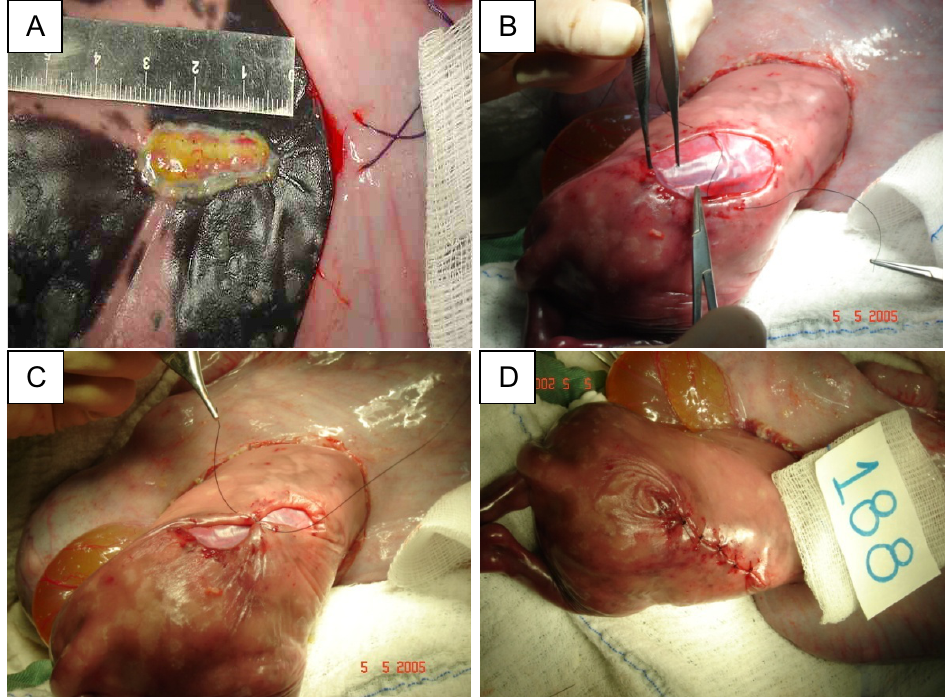
FIGURE 1 - . (A) External aspect of MMC-like defect created at 75 days, after 3 weeks of intrauterine exposure (100 days of gestation), note the striking resemblance of an espina bifida in the human fetus. (B) Skin surrounding defect has been dissected and the interface material is covering the defect. (C) Fetal skin is beginning to be closed. (D) Final aspect of the skin